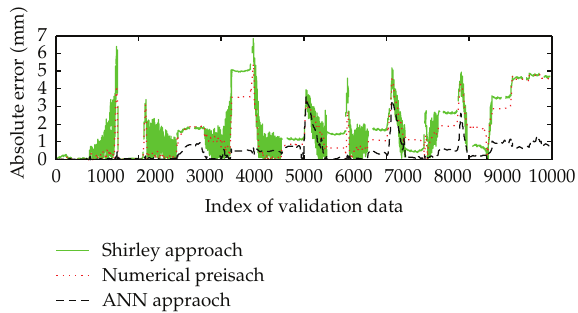
Figure 22: Absolute error of the classical numerical Preisach Model, the proposed ANN model, and the Shirley method in comparison with the second damped experimental data